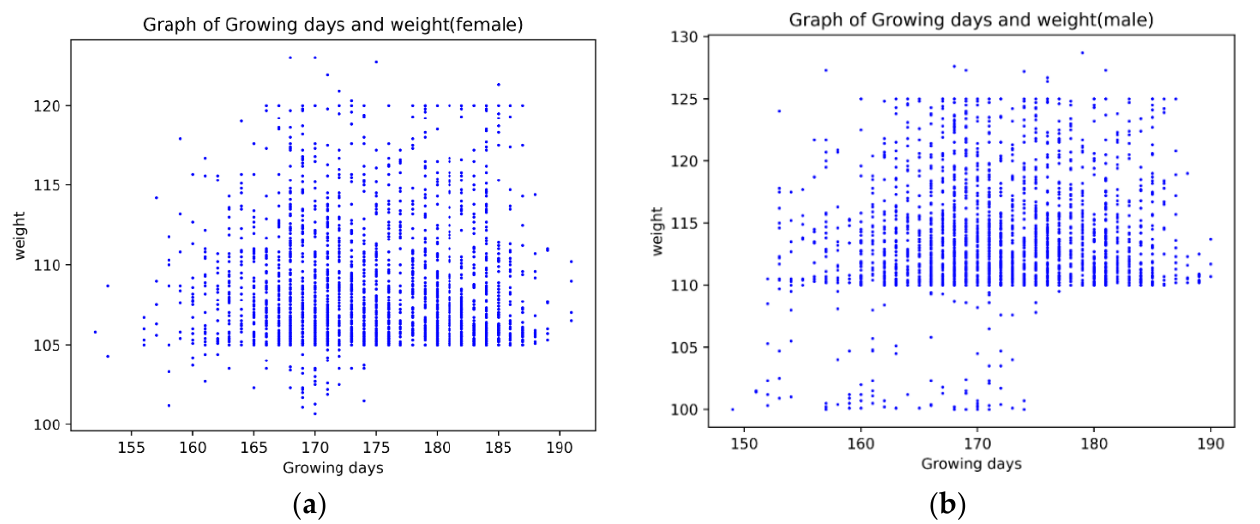
Figure 5. Graph of growing days and weight. ( a ) sows; ( b ) boars.